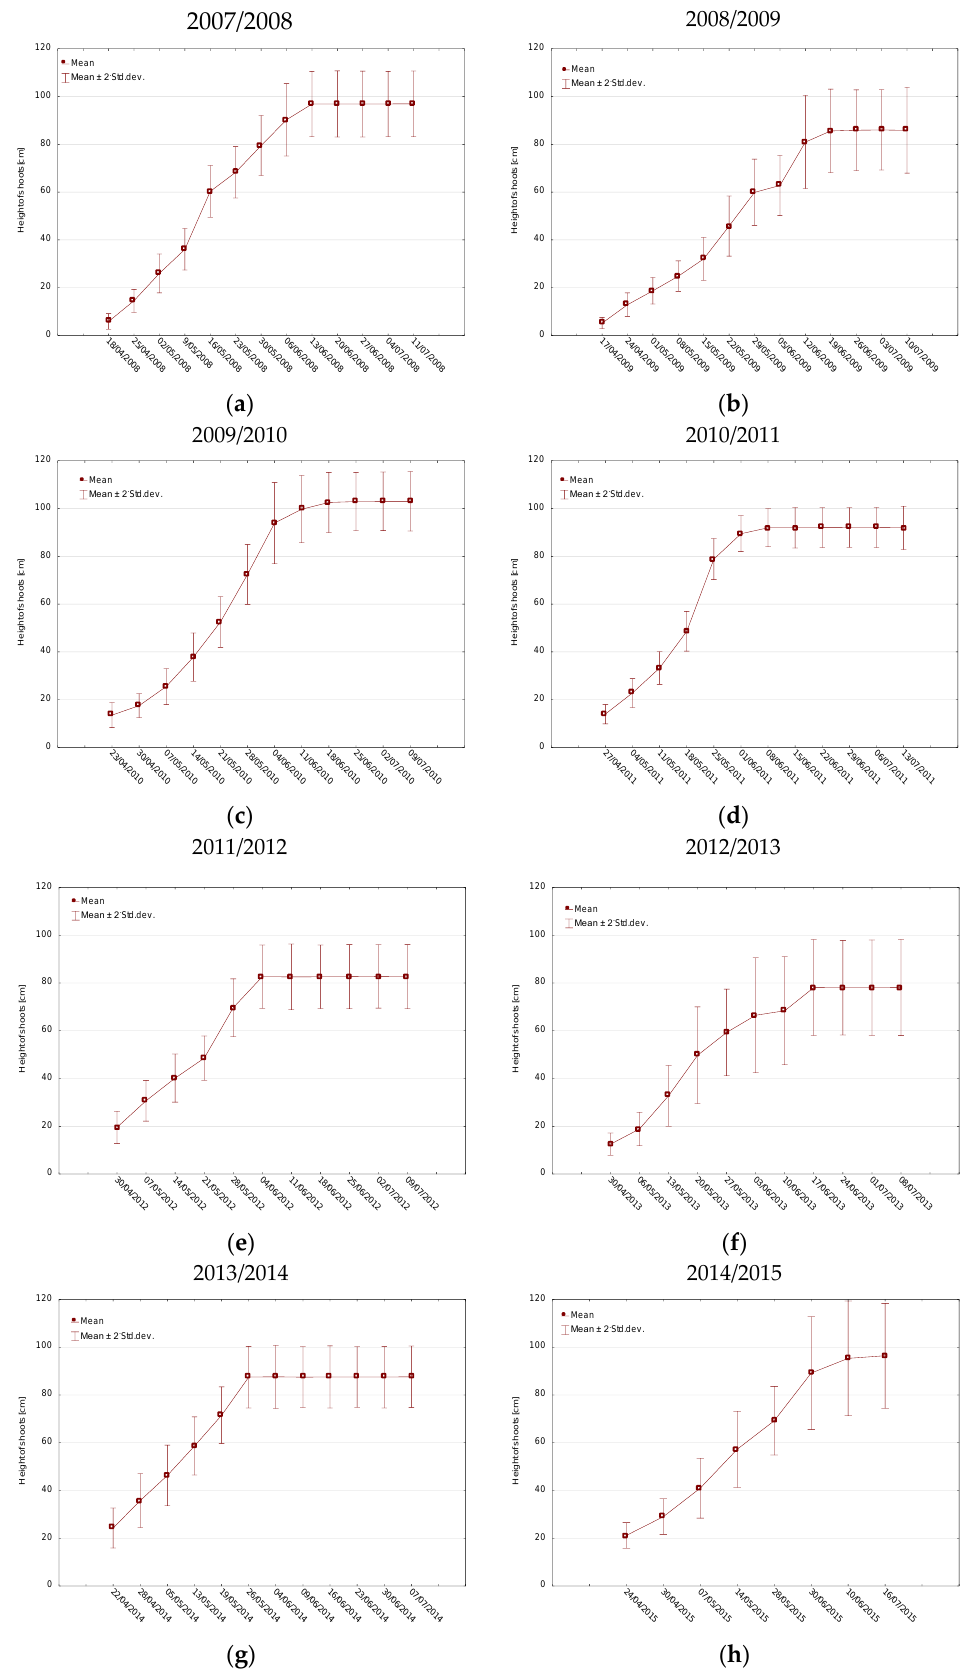
Figure 3. Hight of shoots in following vegetation seasons ( a – h ). Intercalary growth significantly depended on the length of the entire growing period (D), especially the period of vegetative development of winter wheat D (3) and the num- ber of days with precipitation during this period NdP (3), while during the period from sowing to winter dormancy (1), high temperatures negatively affected plant growth (r = −0.34) (Table 2). Table 2. Correlations between plant growth and selected meteorological parameters and the length of development periods. Varible